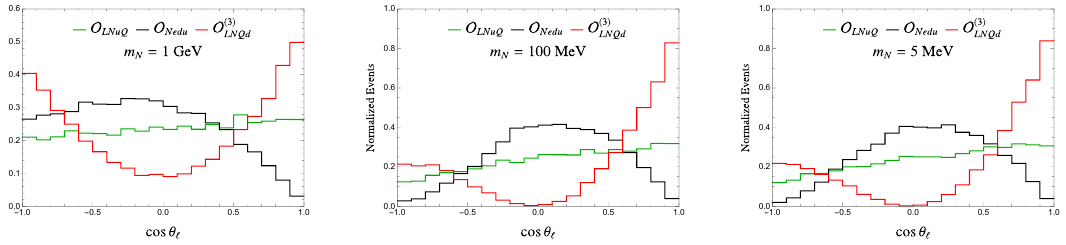
Figure 13 . Same as figure 1, but including the smearing and cuts.